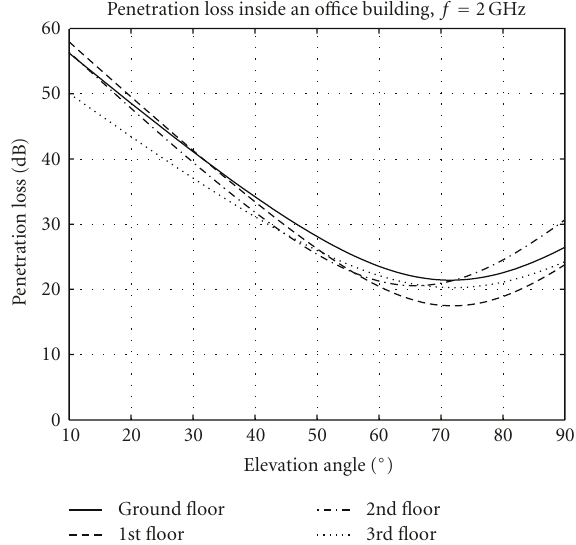
Figure 7: Penetration loss as a function of the elevation angle for a range of floors in an o ffi ce building, f = 2 . 0